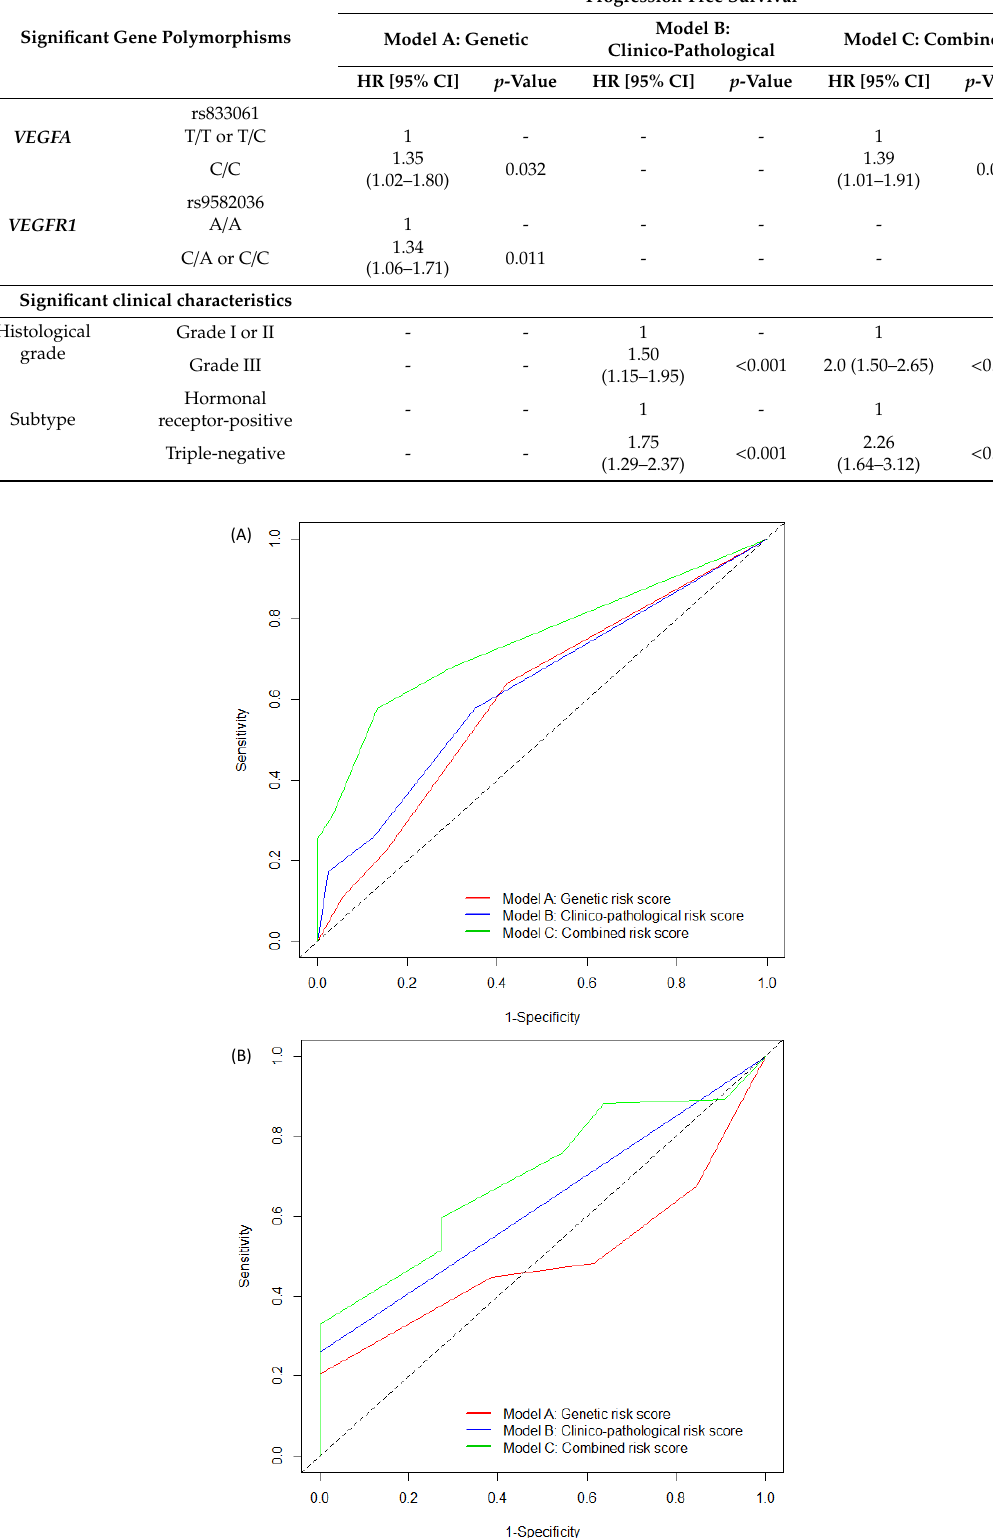
Table 3. Multivariate analysis according to PFS.